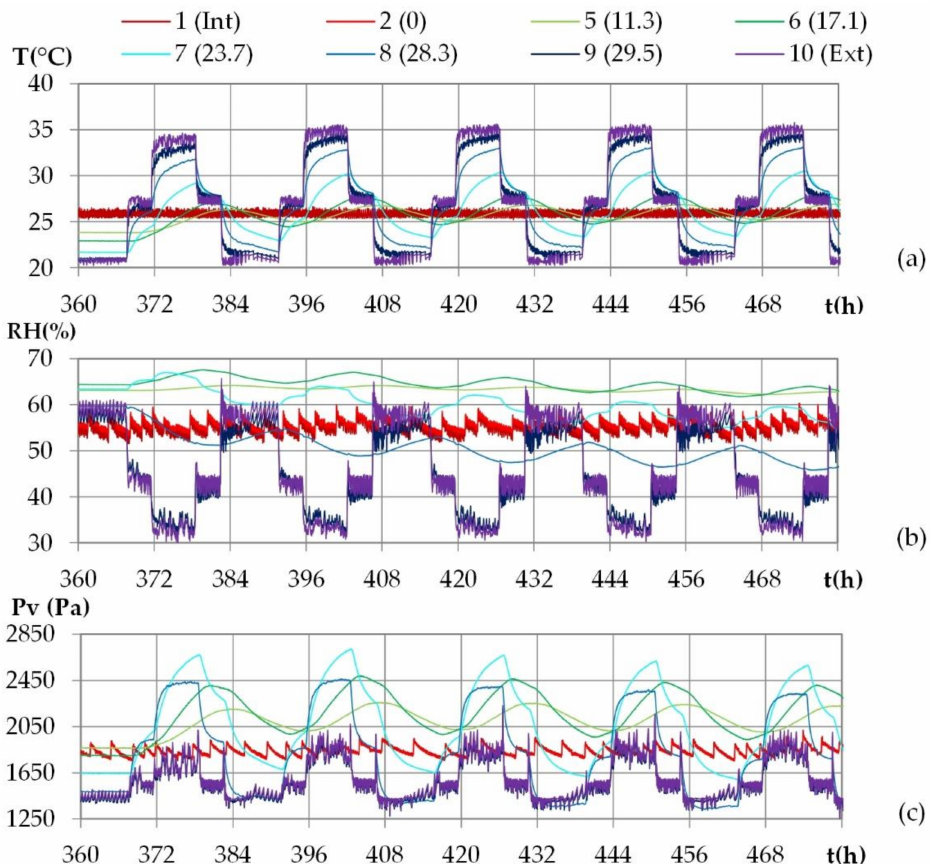
Figure 11. Experimental kinetics of: ( a ) temperature, ( b ) relative humidity and ( c ) vapor pressure during the dynamic cycles at several depths in the wall, for the climate of